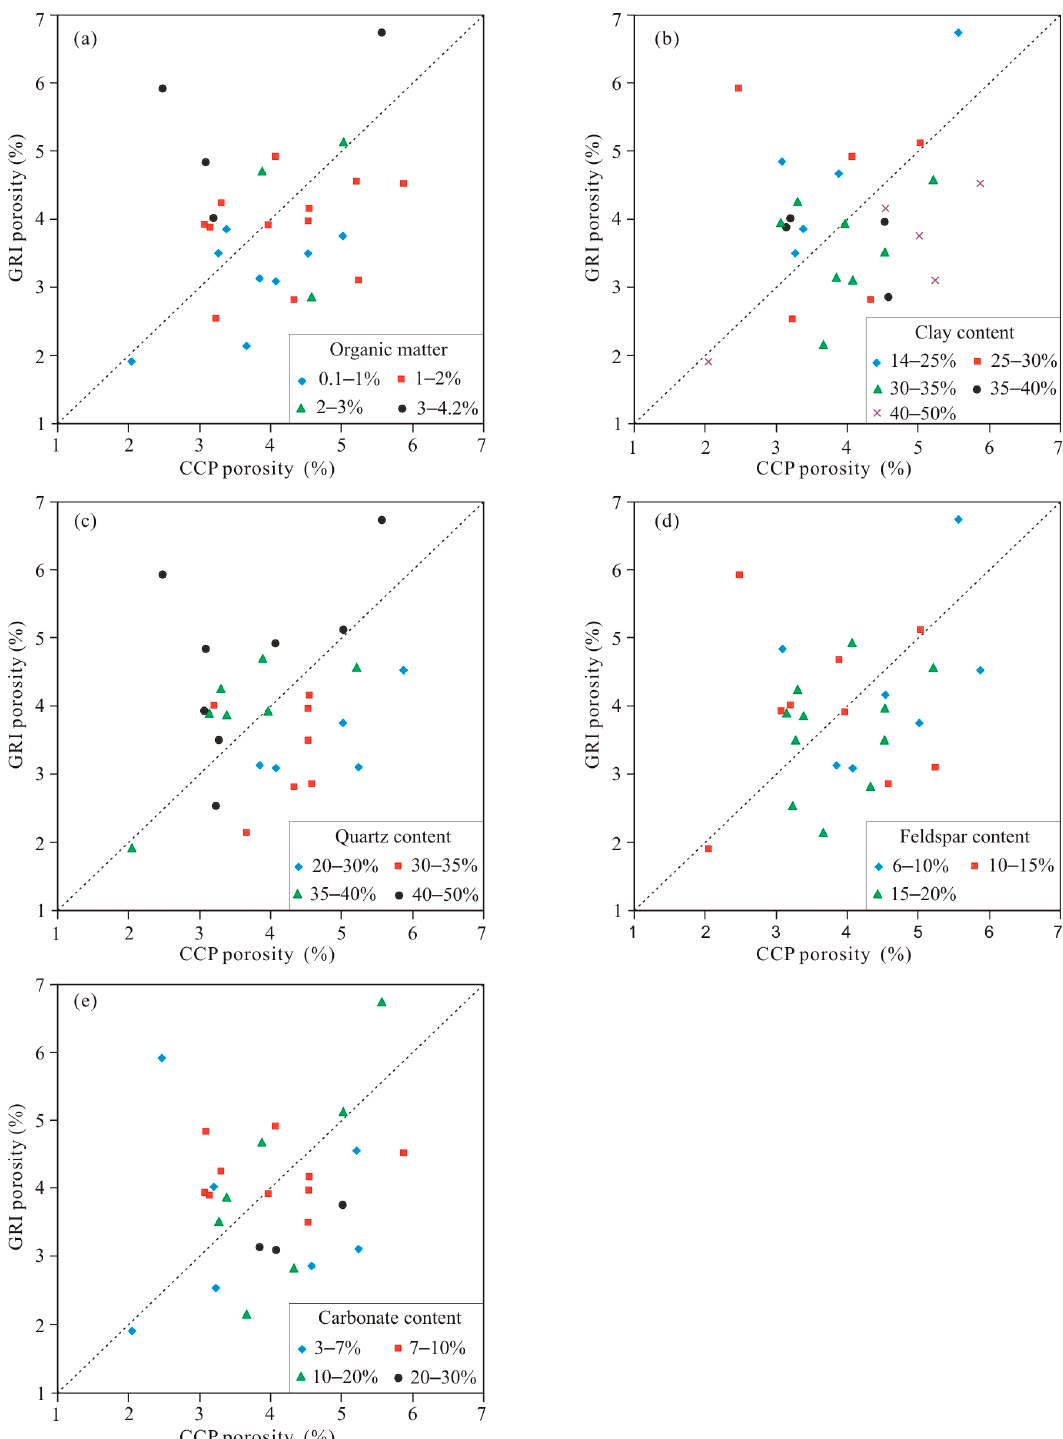
Figure 5. Comparison of the CCP porosity and GRI porosity values (variance σ 2 = 0.0143): ( a ) clay content, ( b ) organic matter content, ( c ) quartz content, ( d ) feldspar content, ( e ) carbonate content.